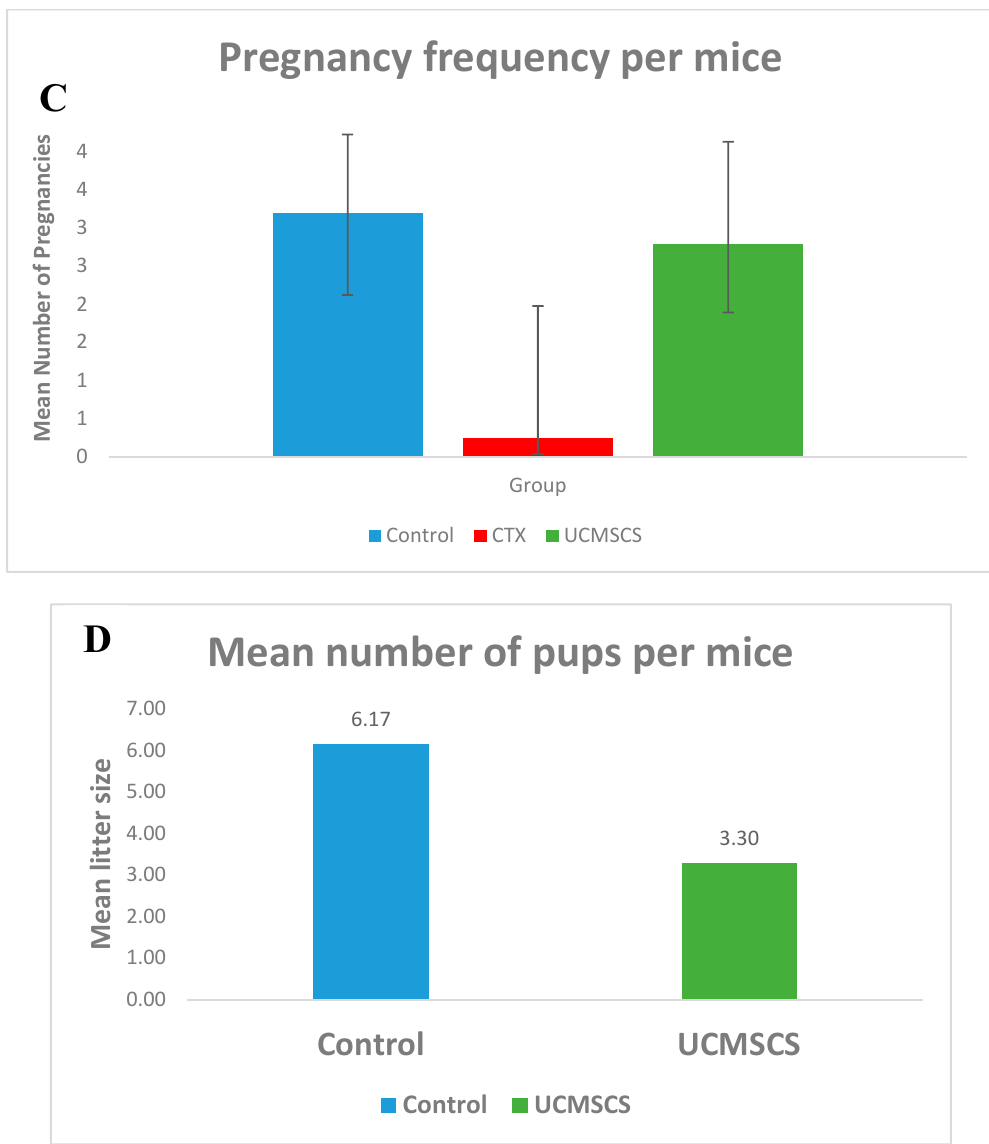
Figure 6: Breeding experiment results, ( A ) and ( B ) UCMSCS group showed more days until pregnancy occur, and slight prolonged pregnancy duration, respectively, however, not statistically significant, ( C ) and ( D ) UCMSCS group exhibited statistical significant data P < 0.05 for both, the number of times mice become pregnant, and how many pups were produced, in order.